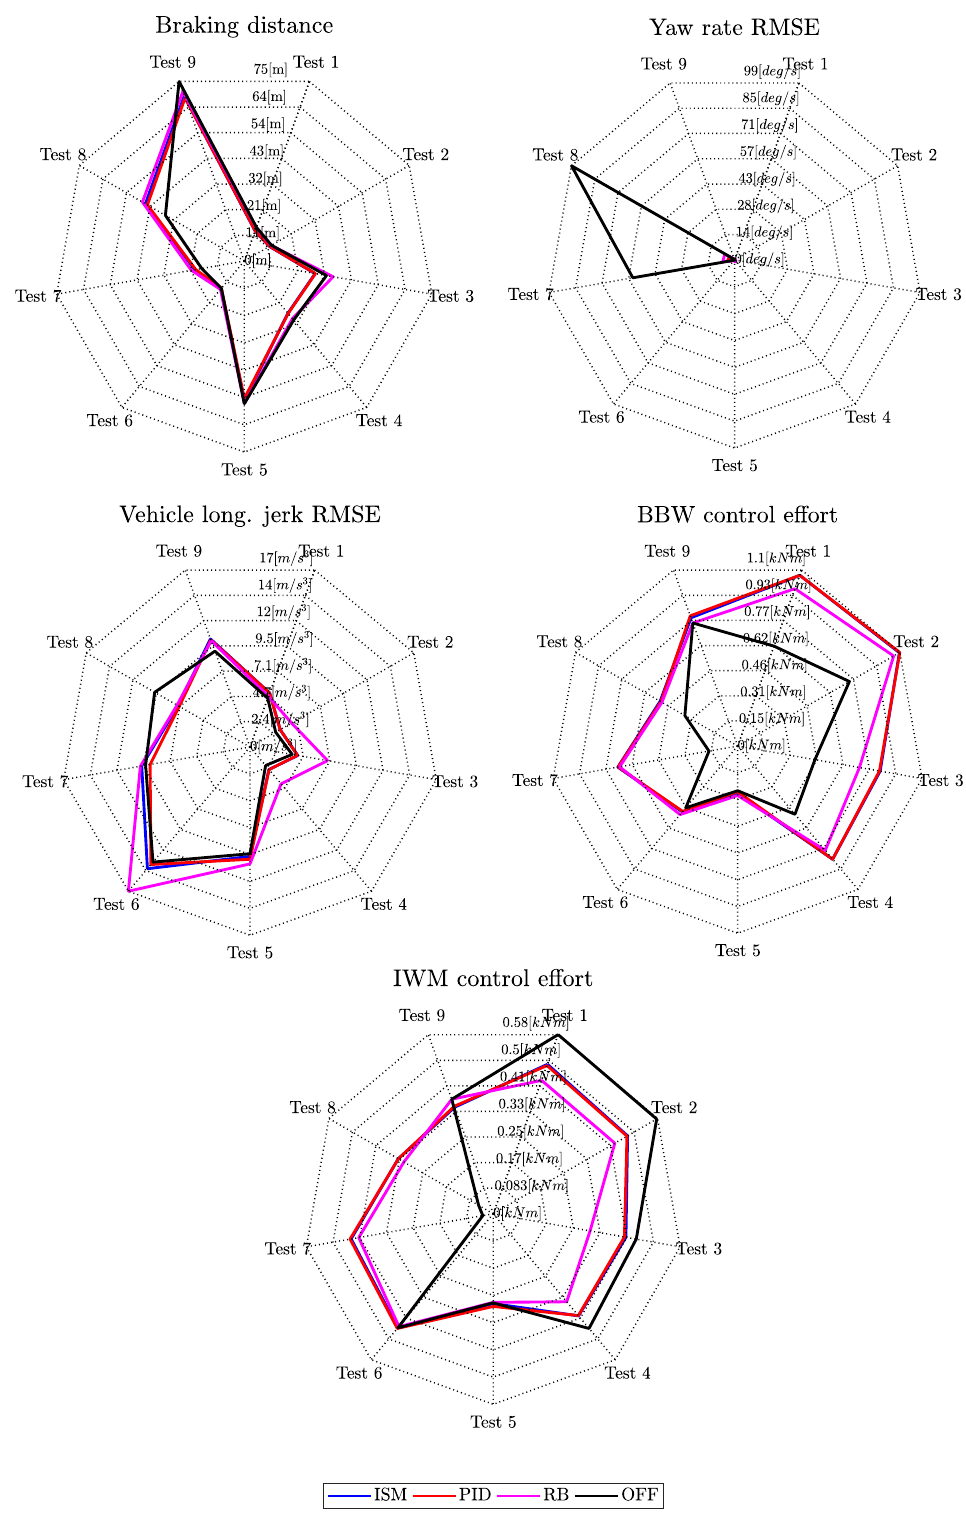
Figure 9. Radar plots of the identified KPIs; torque blending = active.